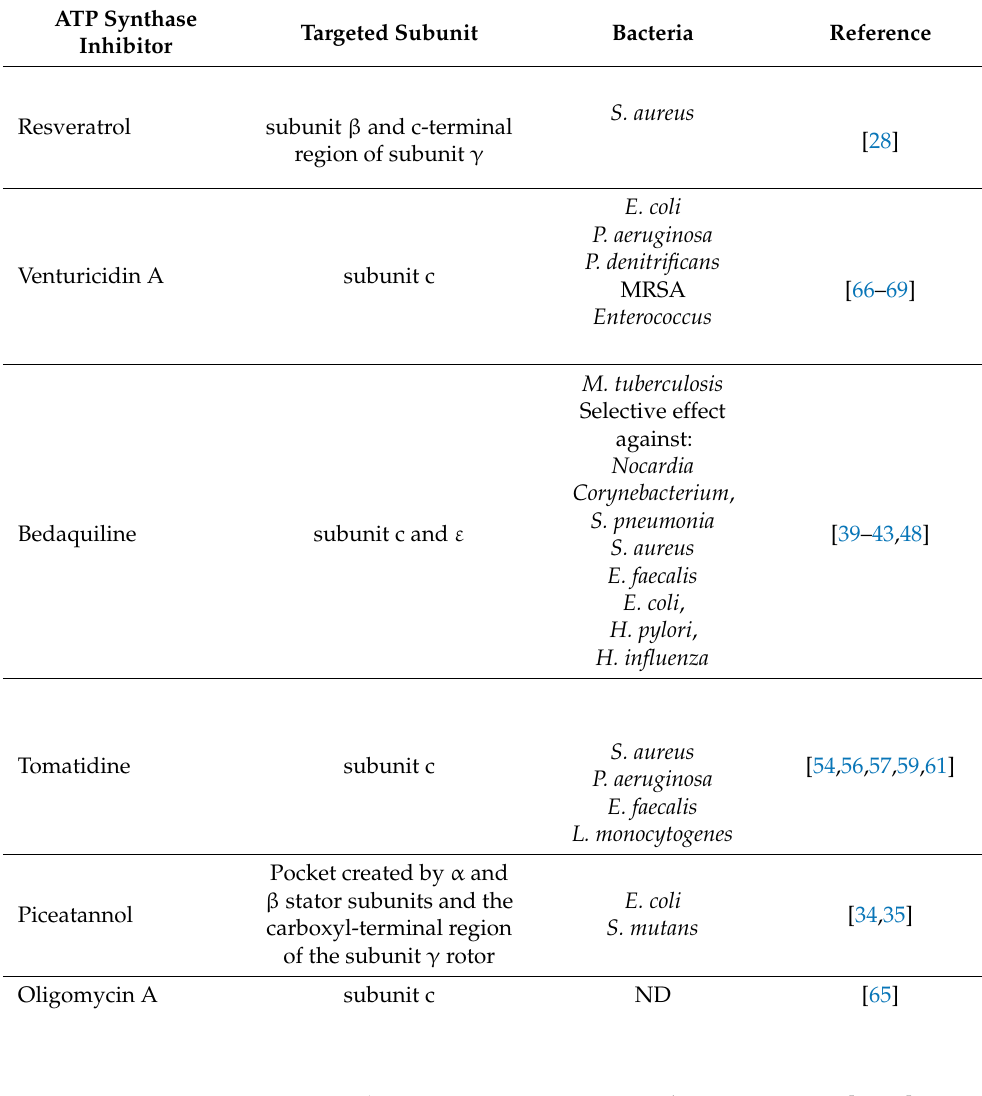
Table 2. Summary of all ATP synthase inhibitors with the different target subunits of the enzyme on selected bacteria. ATP Synthase Targeted Subunit Inhibitor